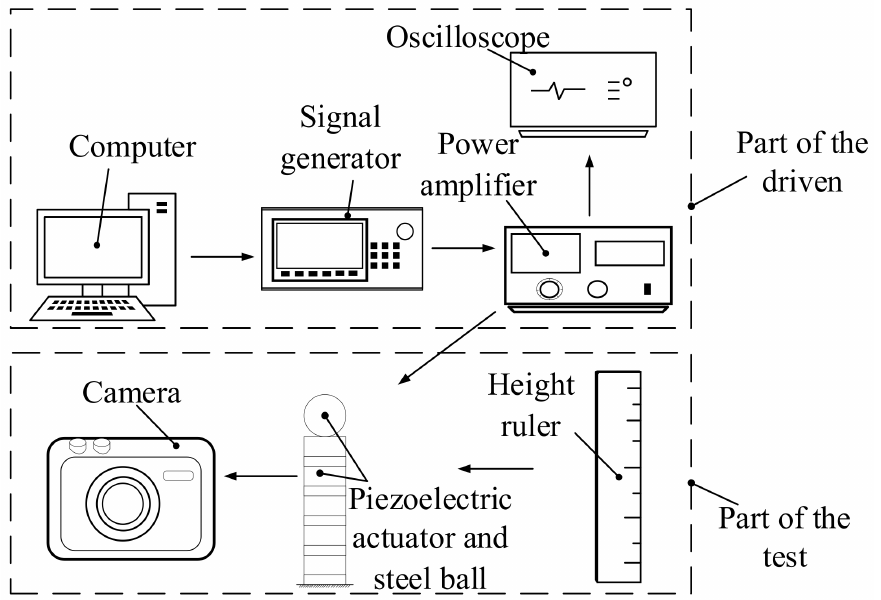
Figure 5. Experimental system diagram of the piezoelectric actuator bouncing the steel ball.